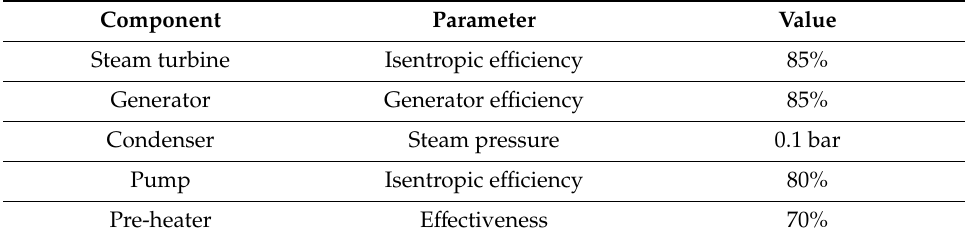
Table 3. Technical parameters for the main components in a power block.